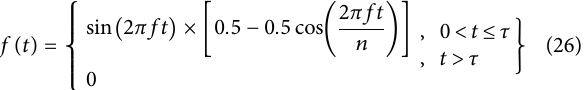
FIGURE 4 Schematic of incentive